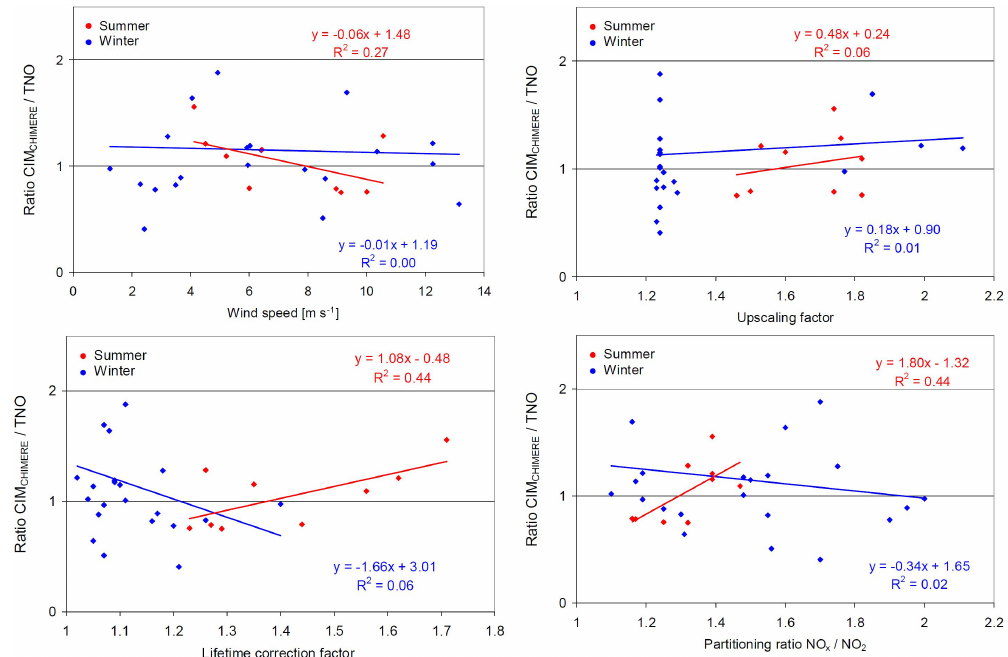
Figure A8. Dependence of the ratio of the derived emissions (CIM CHIMERE ) and TNO NO x emissions on different parameters for summer (red) and winter